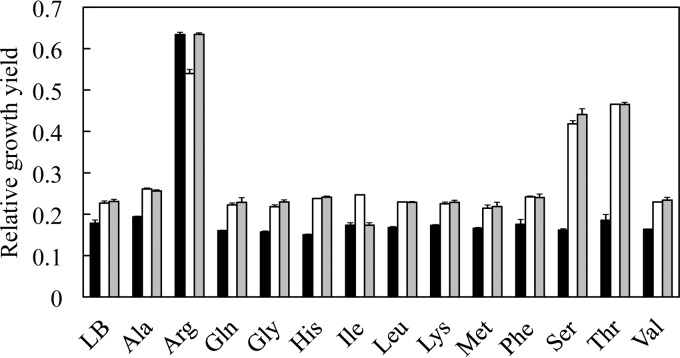
Addition of particular amino acids to growth medium specifically increases the growth yield of an SCV mutant. Shown are relative growth yields of the SCV mutant AH875 (menB D151N [black]), and isogenic evolved strains carrying growth-compensatory mutations in srrA or srrB: AH1208 (srrA M55I [white]) and AH1131 (srrB V420D [gray]). Strains were grown in LB with the addition of the individual amino acids indicated. All values are growth yield relative to the growth yield of the wild type in LB.